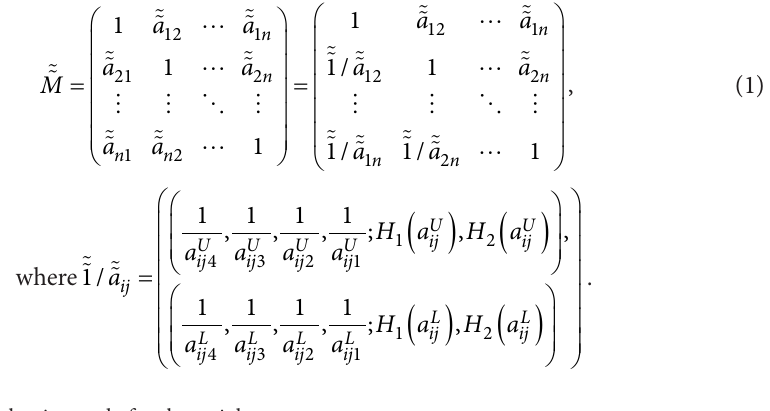
Table 2. Fuzzy evaluation scale for the